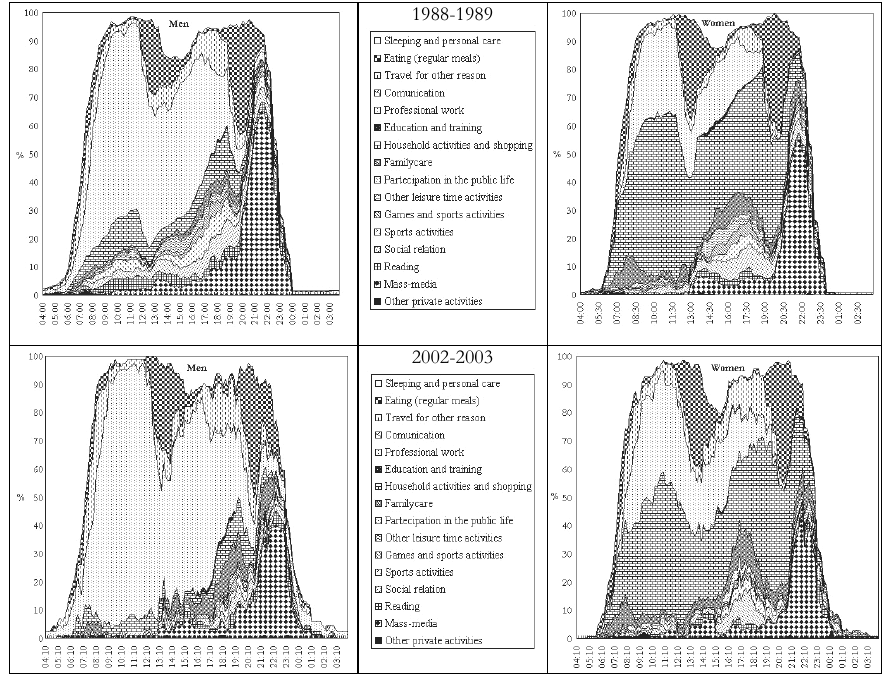
Figure 5 – Workdays of partners by gender. Years 1988-1989 2002-2003 (cumulated frequencies in